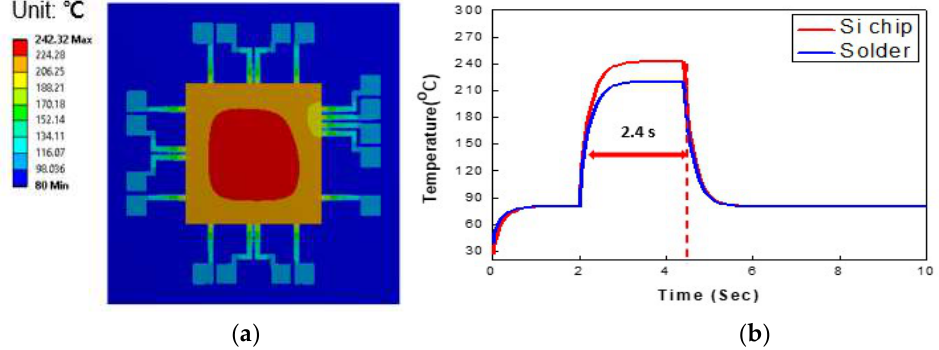
Figure 8. Simulated temperature distribution of the flexible package: ( a ) temperature distribution map of the silicon chip, and ( b ) temperature profile over time simulated with the FEA.